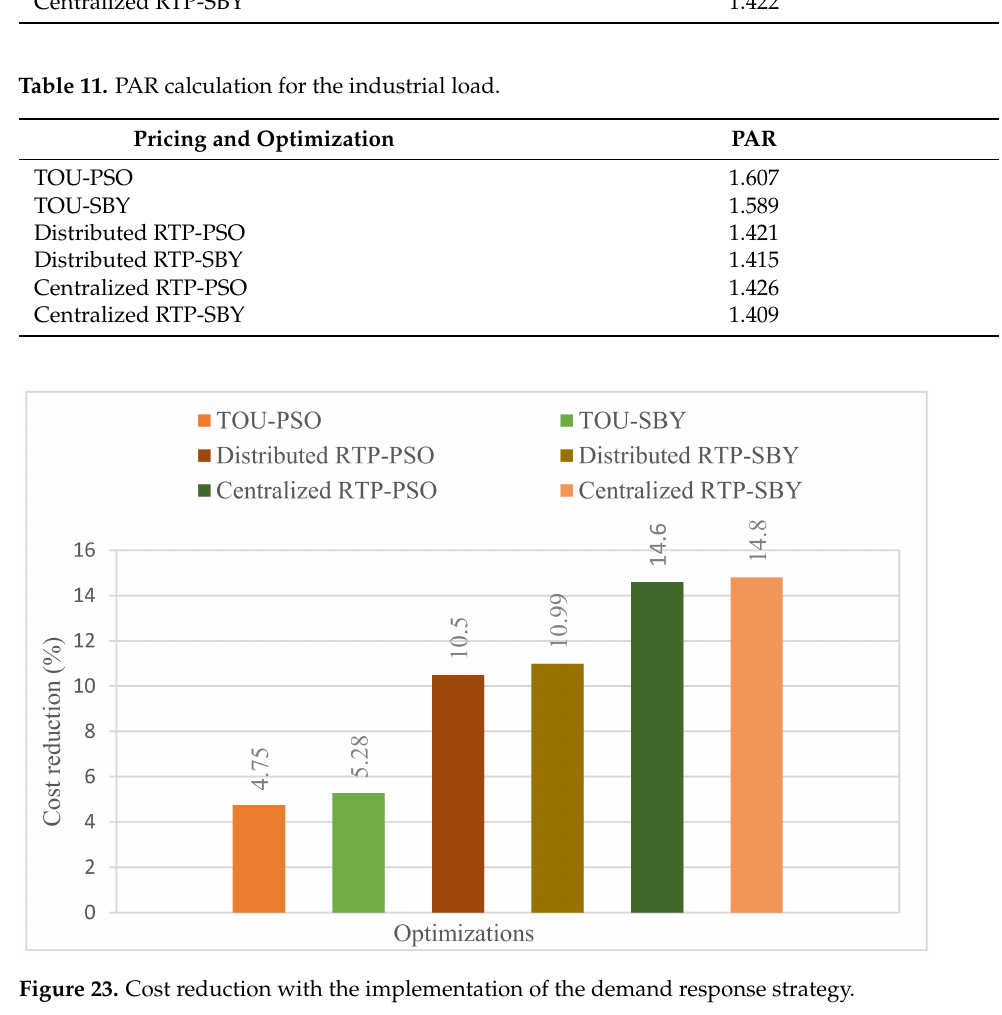
Figure 23. Cost reduction with the implementation of the demand response